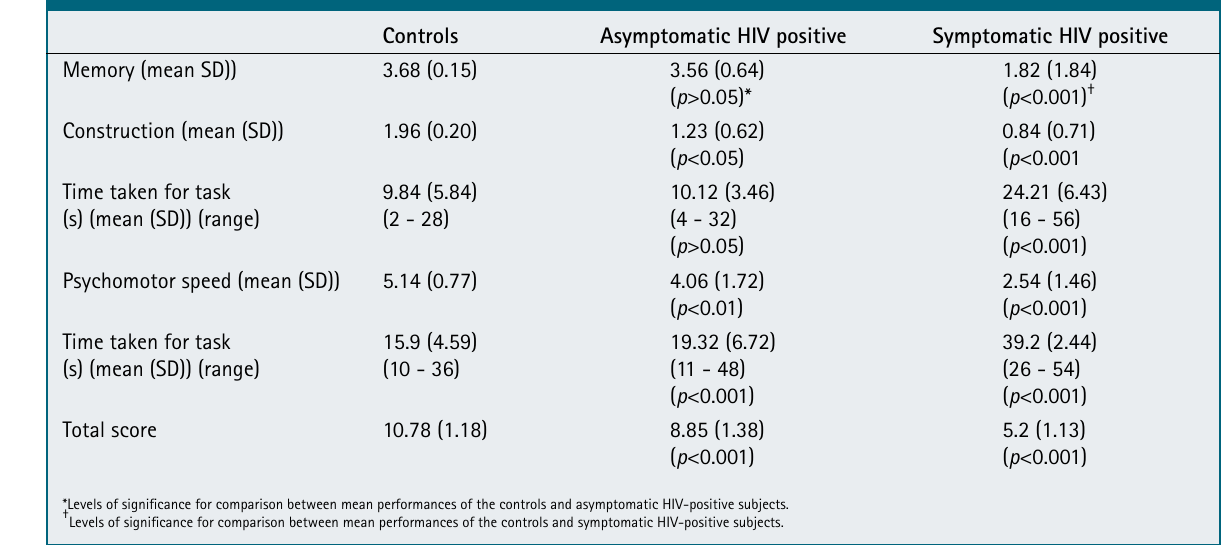
taBle iii. HiV DeMentia Scale ScoreS For tHe SUBJectS